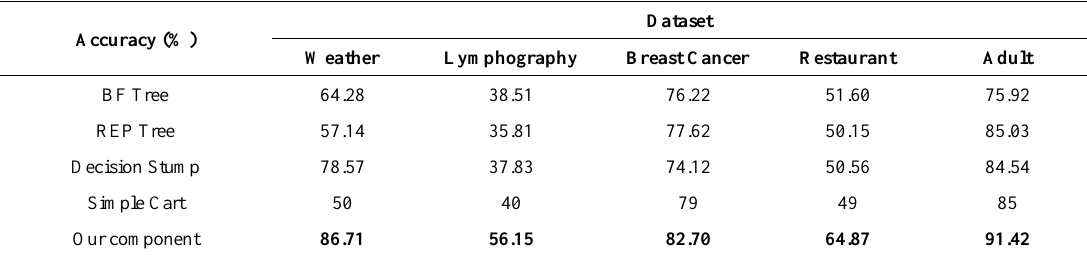
Table 2. Accuracy comparison with baselines on five datasets.